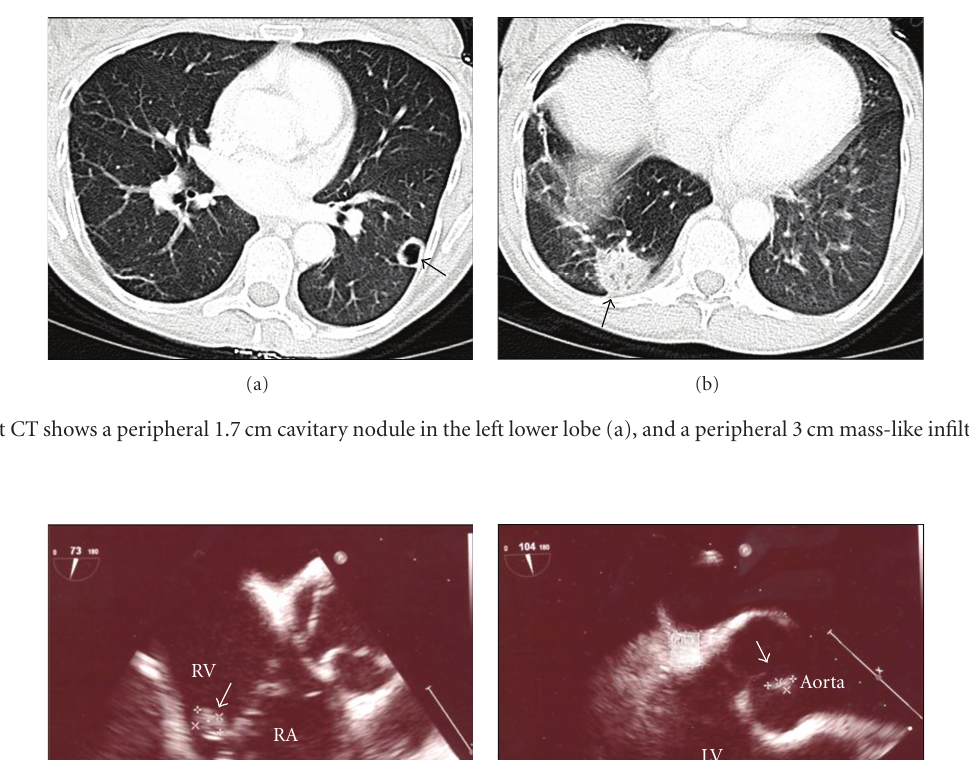
bilirubin 0.9 mg/dl. Chest X-ray showed a nodule in the